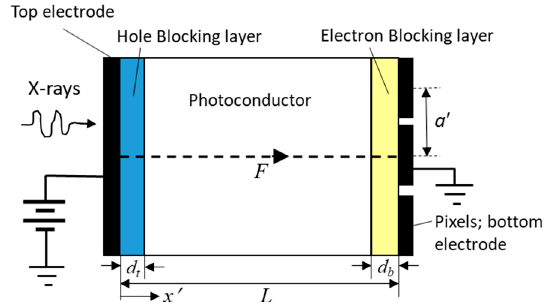
Figure 1. A schematic for the cross-sectional structure of a multilayer X-ray image detector. The n - i - p or p - i - n photoconductor layer is sandwiched between two electrodes. Here, L is the total photoconductor layer thickness and d t and d b are the thicknesses of the top and bottom blocking layers, respectively. The top electrode is biased with a voltage source to establish an electric field F in the photoconductor layer.